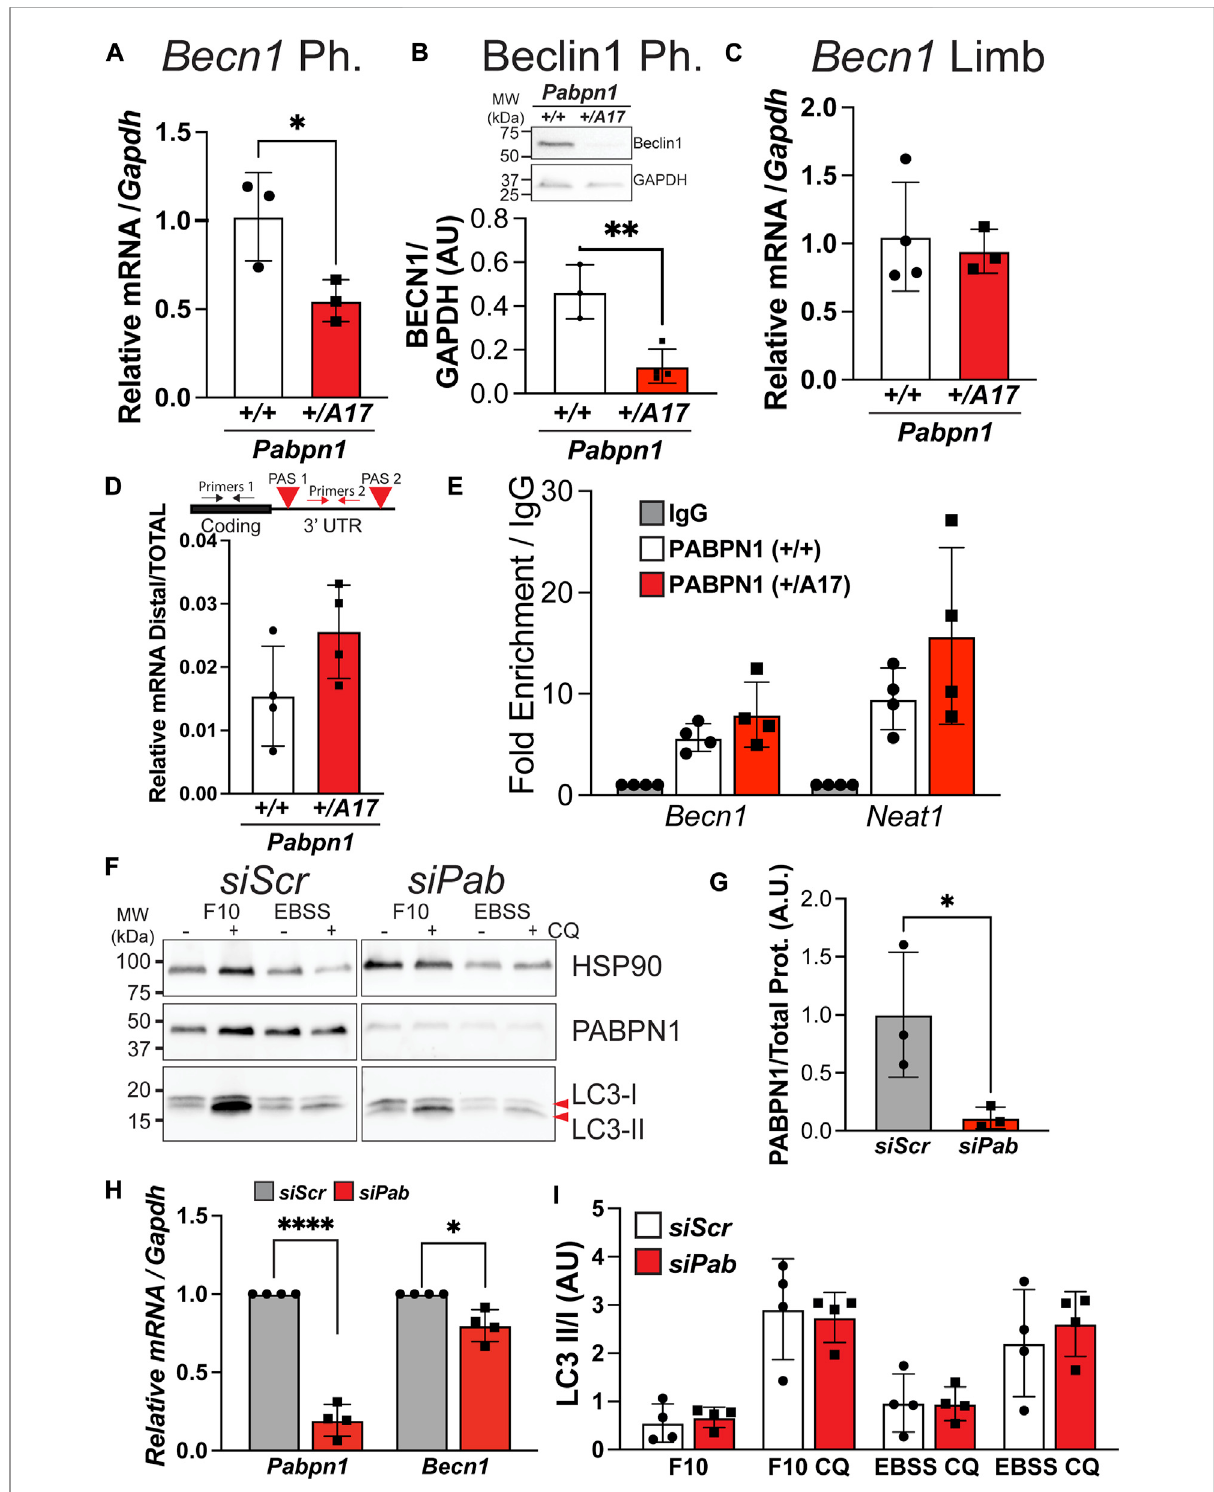
FIGURE 6 Impaired autophagyandlowBecn1 RNAlevels arenotassociated withloss ofPABPN1functioninpharyngeal myoblasts from Pabpn1 +/A17 mice. (A) Steady-statelevelsof Becn1 RNAdeterminedbyqRT-PCRshowingasigni fi cantdecreaseinpharyngeal(Ph.)myoblastsfrom Pabpn1 +/A17 mice. (B) Levels of Beclin 1 protein as determined by immunoblot show a signi fi cant decrease in pharyngeal myoblasts from Pabpn1 +/A17 mice. GAPDH was usedasaloadingcontrol. (C) Steady-statelevelsof Becn1 RNAdeterminedbyqRT-PCRshowingnochangeinlimbmyoblasts from Pabpn1 +/A17